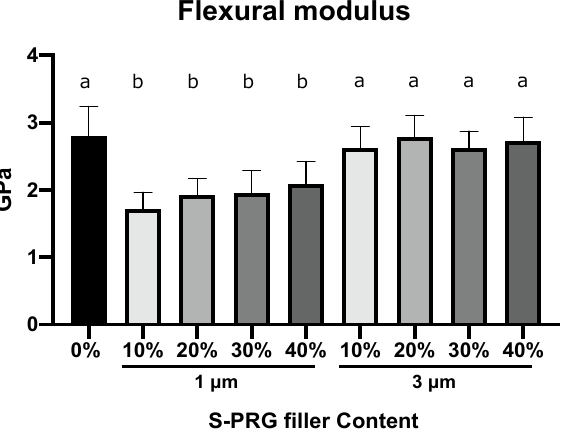
Figure 3. Flexural modulus. The bars represent mean values ± standard deviation ( n = 12). Different letters indicate statistical significance ( p < 0.05).